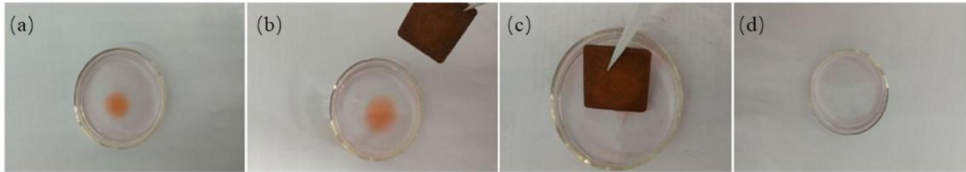
Figure 5. Optical images of copper foam for the cleanup of hexane on the water surface ( a – d